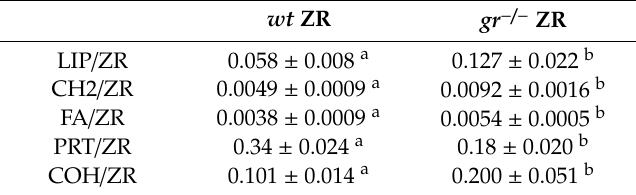
Table 4. Biochemical composition of the zona radiata of class IV wt and gr − / − oocytes. wt ZR gr − / − ZR LIP / ZR 0.058 ± 0.008